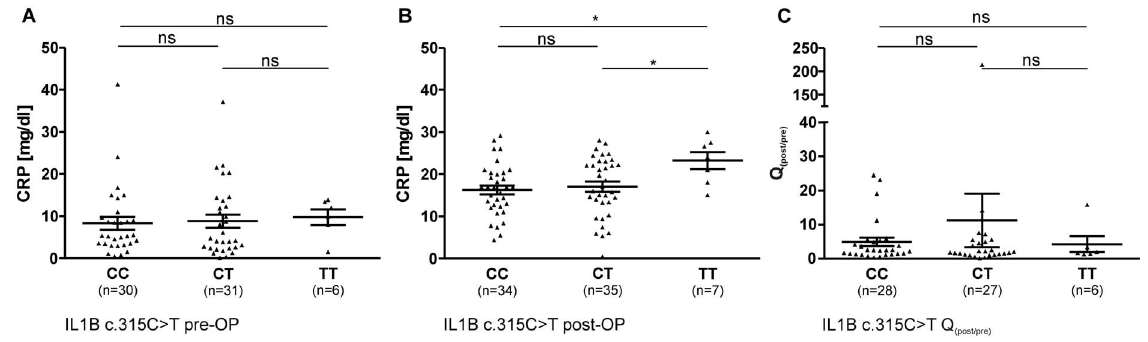
Figure 1. Pre- (A) and postoperative (B) CRP levels (mean ± SEM), as well as factorial change Q (post/pre) of CRP (C) in the course of surgical intervention in patient sera in correlation with IL1B c.315C . T genotype (ns: not significant; *=P , 0.05).